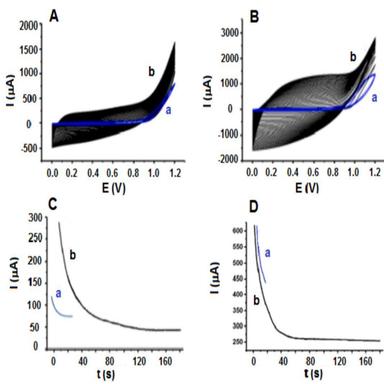
EDOT polymerization curves: A) 5 mM EDOT solution a) 3 cycles, b) 30 cycles using cyclic voltammetry, B) 50 mM EDOT solution a) 3 cycles, b) 30 cycles using cyclic voltammetry, C) 5 mM EDOT solution a) 30 s, b) 180 s using constant potential electrolysis, D) 50 mM EDOT solution a) 30 s, b) 180 s using constant potential electrolysis.